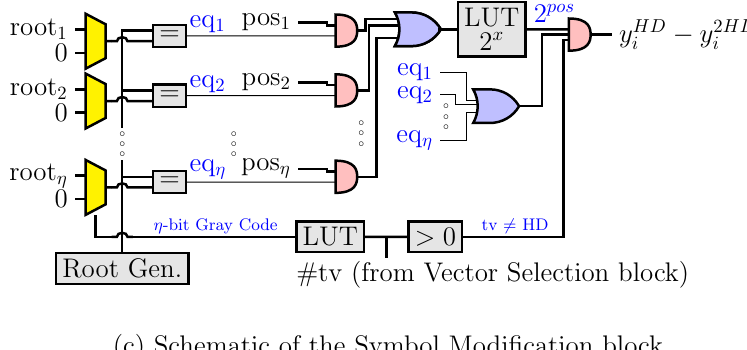
Figure 6. Schematics for different blocks of the proposed